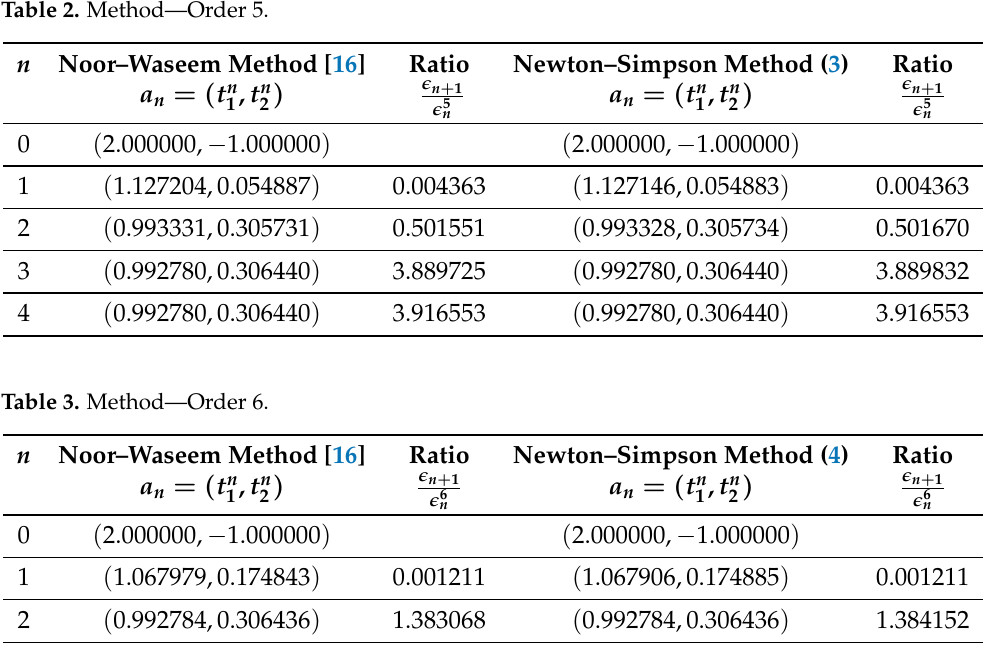
Table 2. Method—Order 5.